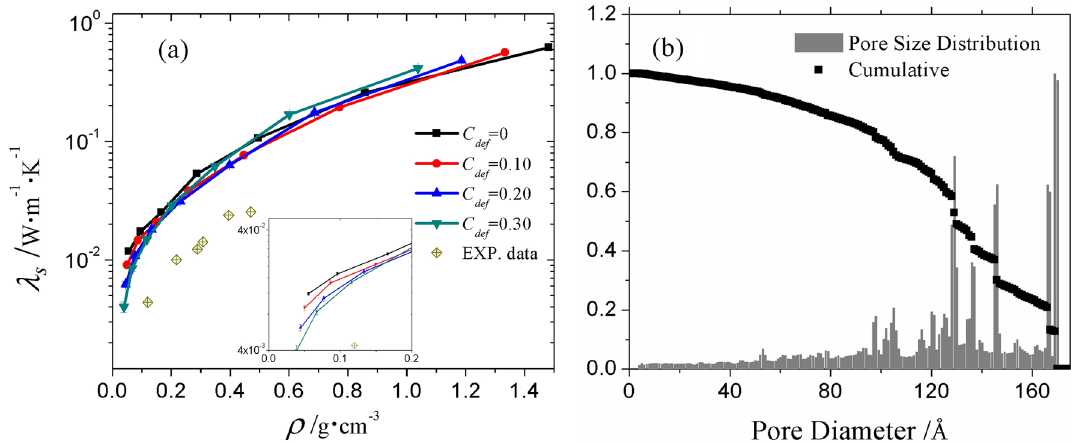
Figure 5. ( a ) The solid thermal conductivity (cid:31) s as a function of aerogel density ρ at various defect concentrations together with experimental data from reference 20 , ( b ) The pore size distribution of the aerogel solid skeleton at ρ = 0.0557 gcm − 3 and C def =